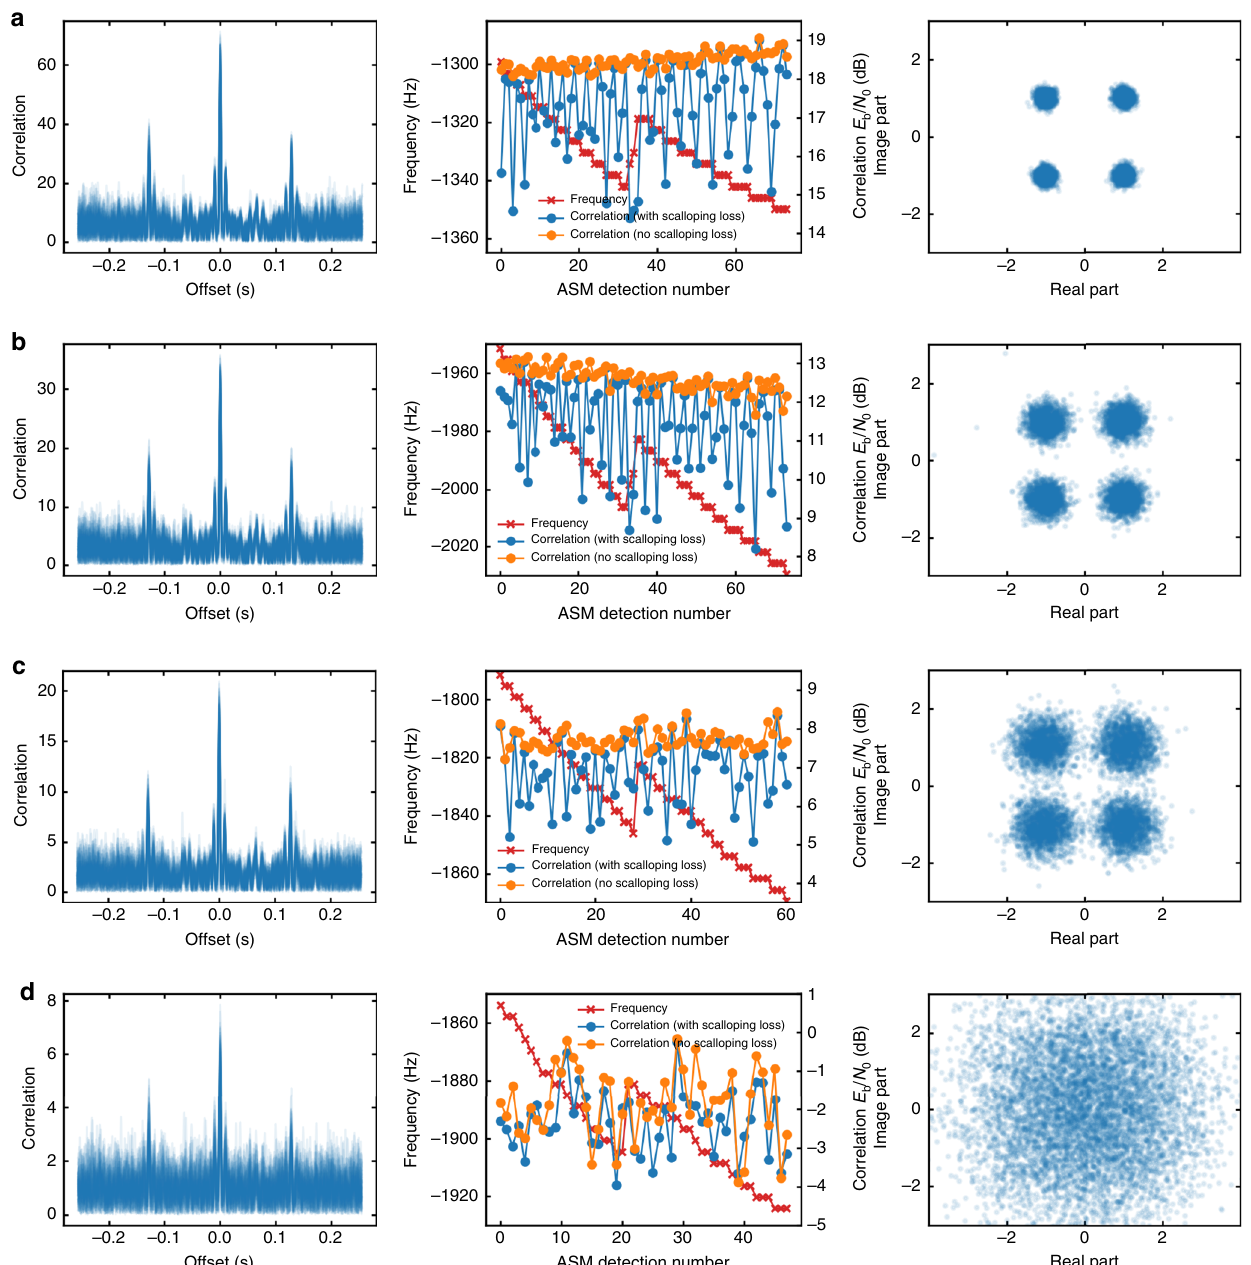
Fig. 5 Downlink performance of Longjiang-2 received by different ground stations. Correlation peaks, ASM detected, and constellation plots received at a Dwingeloo, b Wakayama, c Shahe, and d